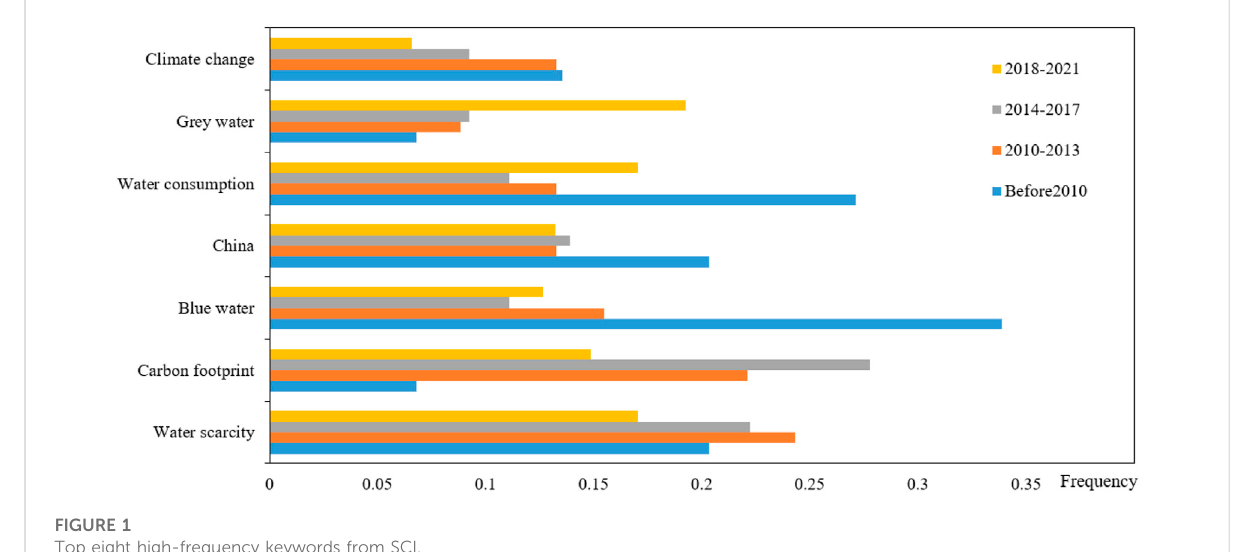
Top eight high-frequency keywords from